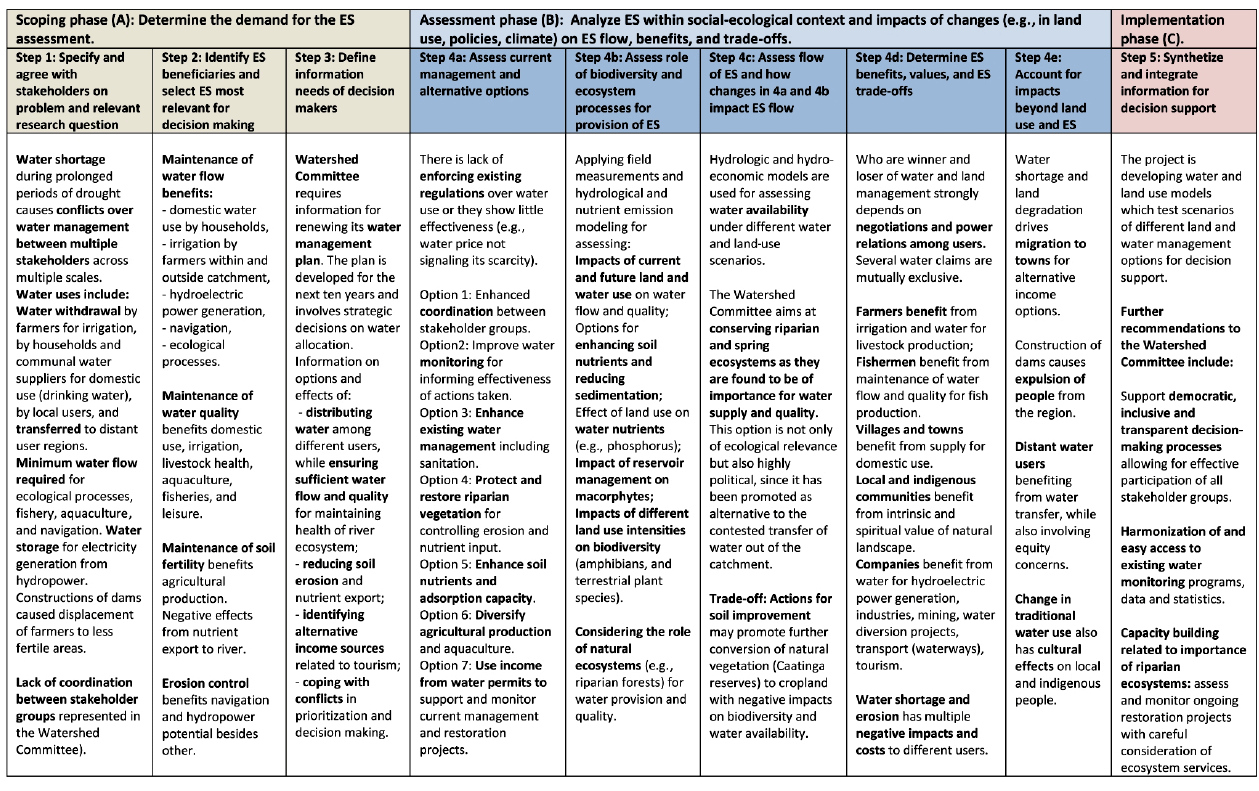
Fig. 5 . Problem-oriented approach for assessing ecosystem services (ES): the case of the INNOVATE project in the River São Francisco Watershed in